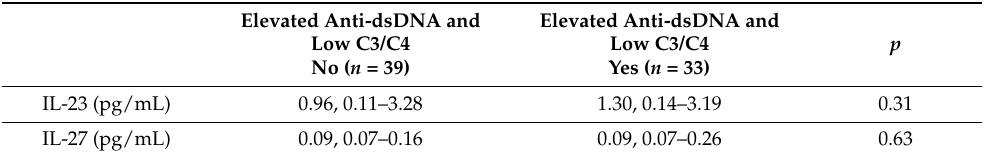
Table 6. Differences in IL-23 and IL-27 (median, min–max) between patients with and without elevated anti-dsDNA and decreased